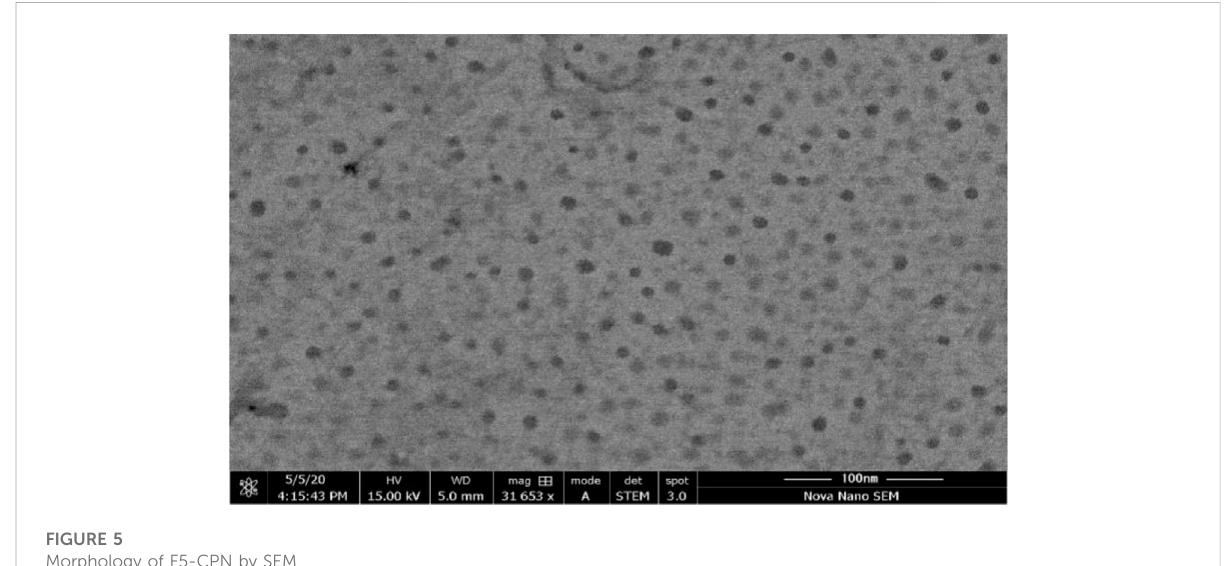
FIGURE 5 Morphology of F5-CPN by